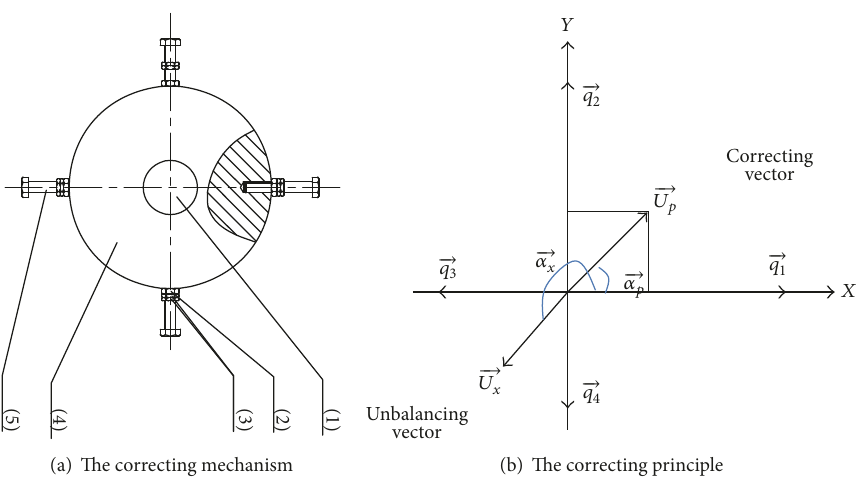
Figure 4: An adjustable dynamic balancing mechanism. Notes . (1) Crankshaft, (2) lock nut, (3) adjusting nut, (4) flywheel, and (5) long bolt. vectors at 0 ∘ , 90 ∘ , 180 ∘ , and 270 ∘ of flywheel are set as 󳨀→ 󳨀→ ∠0 ∘ , 𝑞 = 𝑄 ∠90 ∘ , 𝑞 = 𝑄 ∠180 ∘ , and 𝑄 1 2 2 3 3